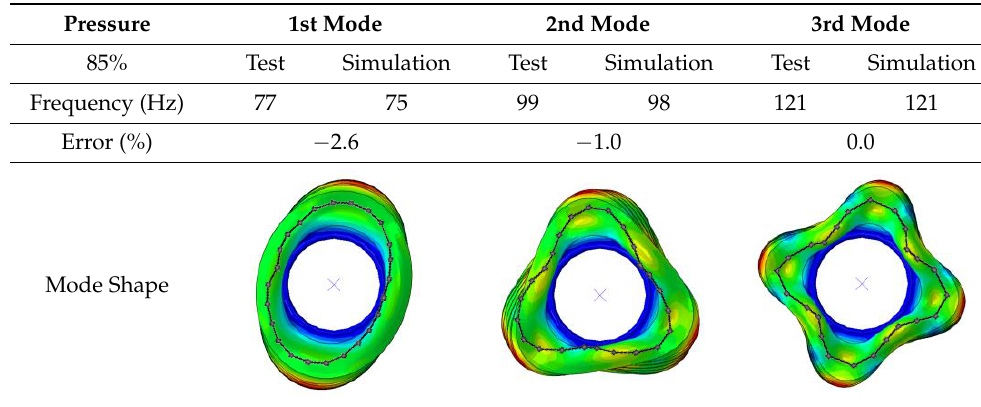
Figure 11. Tire simulation results for the vertical stiffness under the vertical load of 4150 kgf and internal pressure of 896 kPa. Table 6. Comparison of the modal frequencies and modal shapes between the experiment and simulation (Pressure 85%).